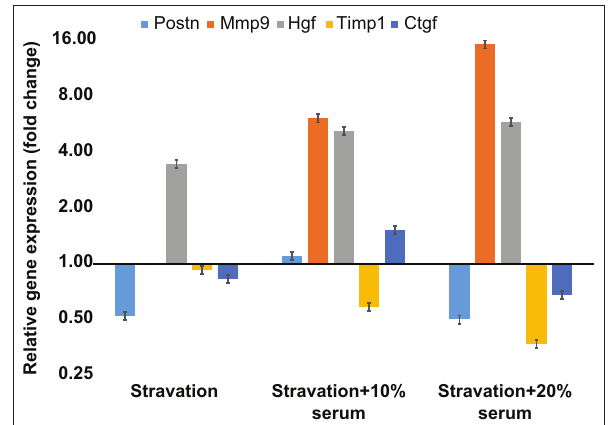
Figure-7: The effect of starvation and reintroduction of serum. Gene expression was calculated relative to a control culture (10% serum). Change of matrix metallopeptidase 9 and tissue inhibitor of metalloproteinase 1 expression in cardiac fibroblasts was statistically altered (p<0.05) by increased serum concentration, whereas hepatocyte growth factor expression was significantly altered (p<0.05) by both starvation and elevated serum concentration. Cell culture was done in six replications, while quantitative polymerase chain reaction was done in three